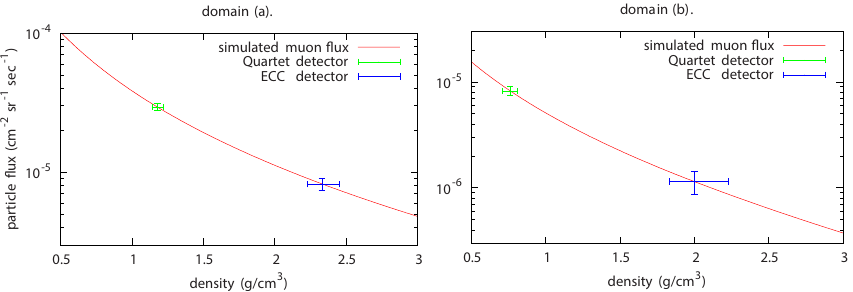
Fig. 10. Simulated muon flux against assumed density for two angular domains, (a) left and (b) right. The particle fluxes observed in the quartet and ECC detectors are shown by green and blue vertical error bars (1 σ ). The estimated density values are shown by the horizontal error bars. Table 1. The number of the selected tracks for the three angular domains (a), (b), and (c) for the quartet detector (top) and ECC detector (bottom). The last rows show the particle fluxes with efficiency compensation using (cid:15) tot values for each inclination